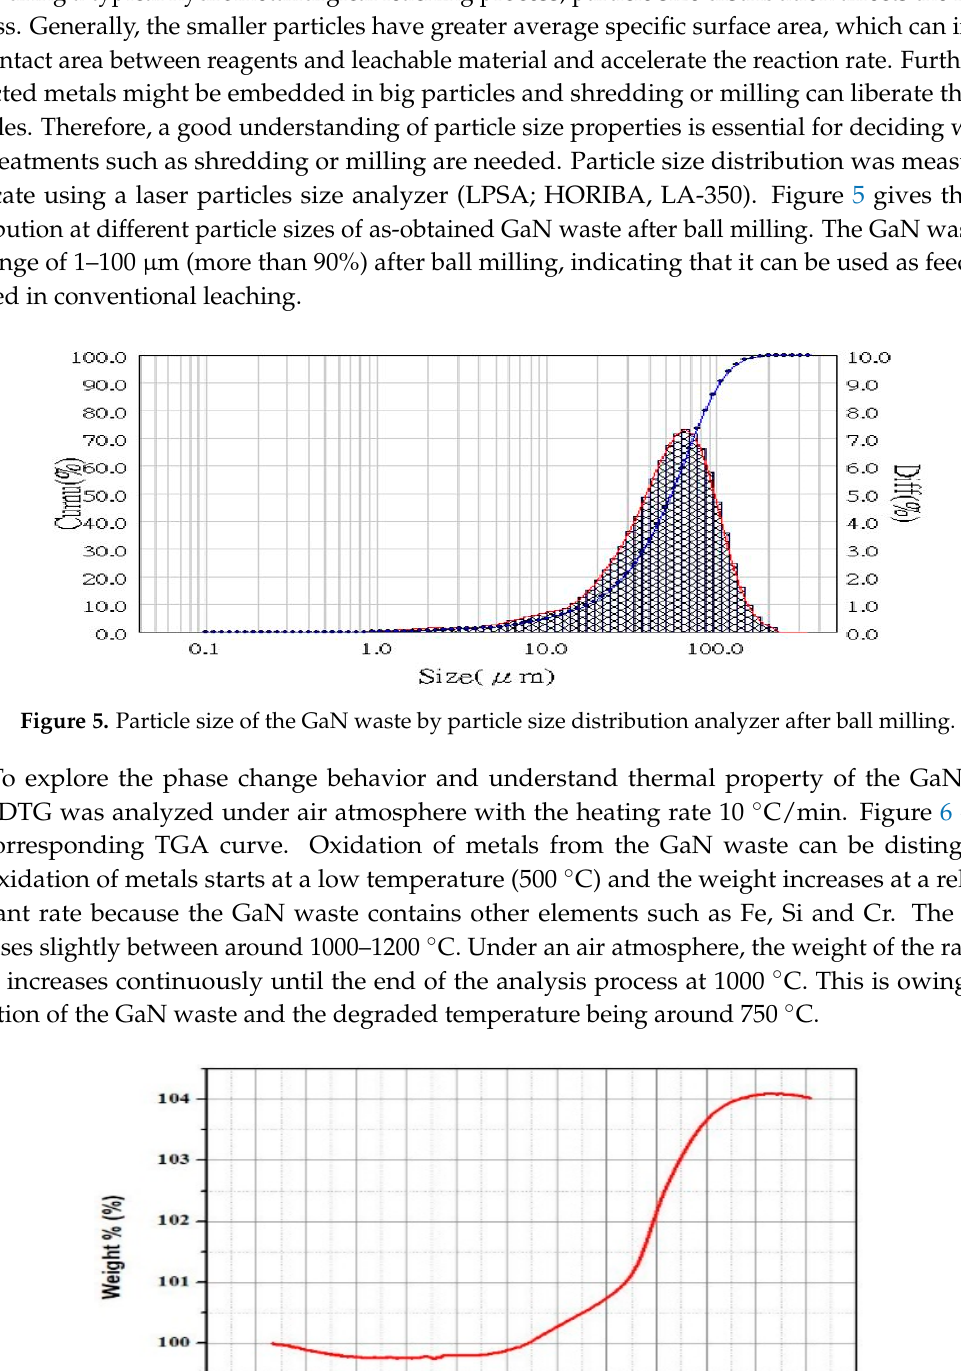
Table 1. The composition of the GaN waste analyzed by X-ray fluorescence analyzer (XRF).